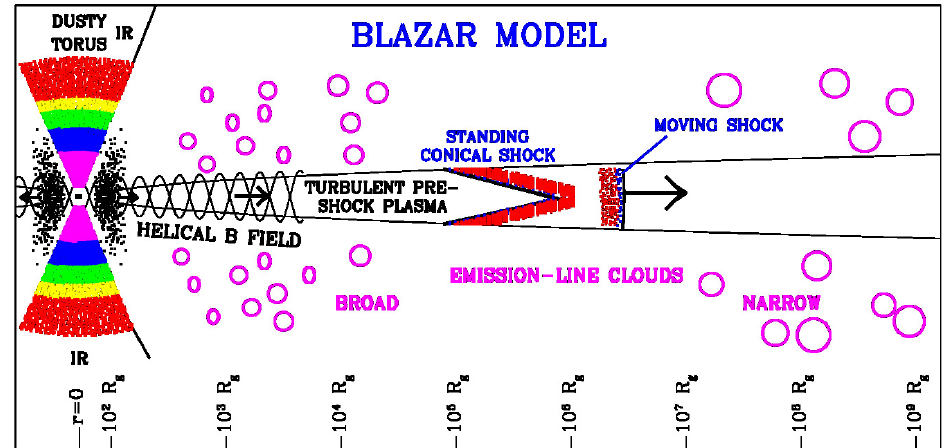
Figure 2. Sketch of the blazar model considered here. The linear scale is logarithmic (in units of the gravitational radius R g ) in order to fit all features into a single frame. The central engine on the left consists of a super-massive black hole surrounded in the equatorial region by an accretion disk whose temperature decreases outward, beyond which there is a hot (~1200–1500 K), dusty molecular torus. Other features are marked. The thin blue regions next to the shock fronts represent the location of X-ray synchrotron emission, while the adjacent red regions correspond to lower-frequency (optical-IR) emission. The irregularities in the X-ray (blue) regions signify that only some turbulent cells have electrons of sufficiently high energies to emit synchrotron radiation at X-ray